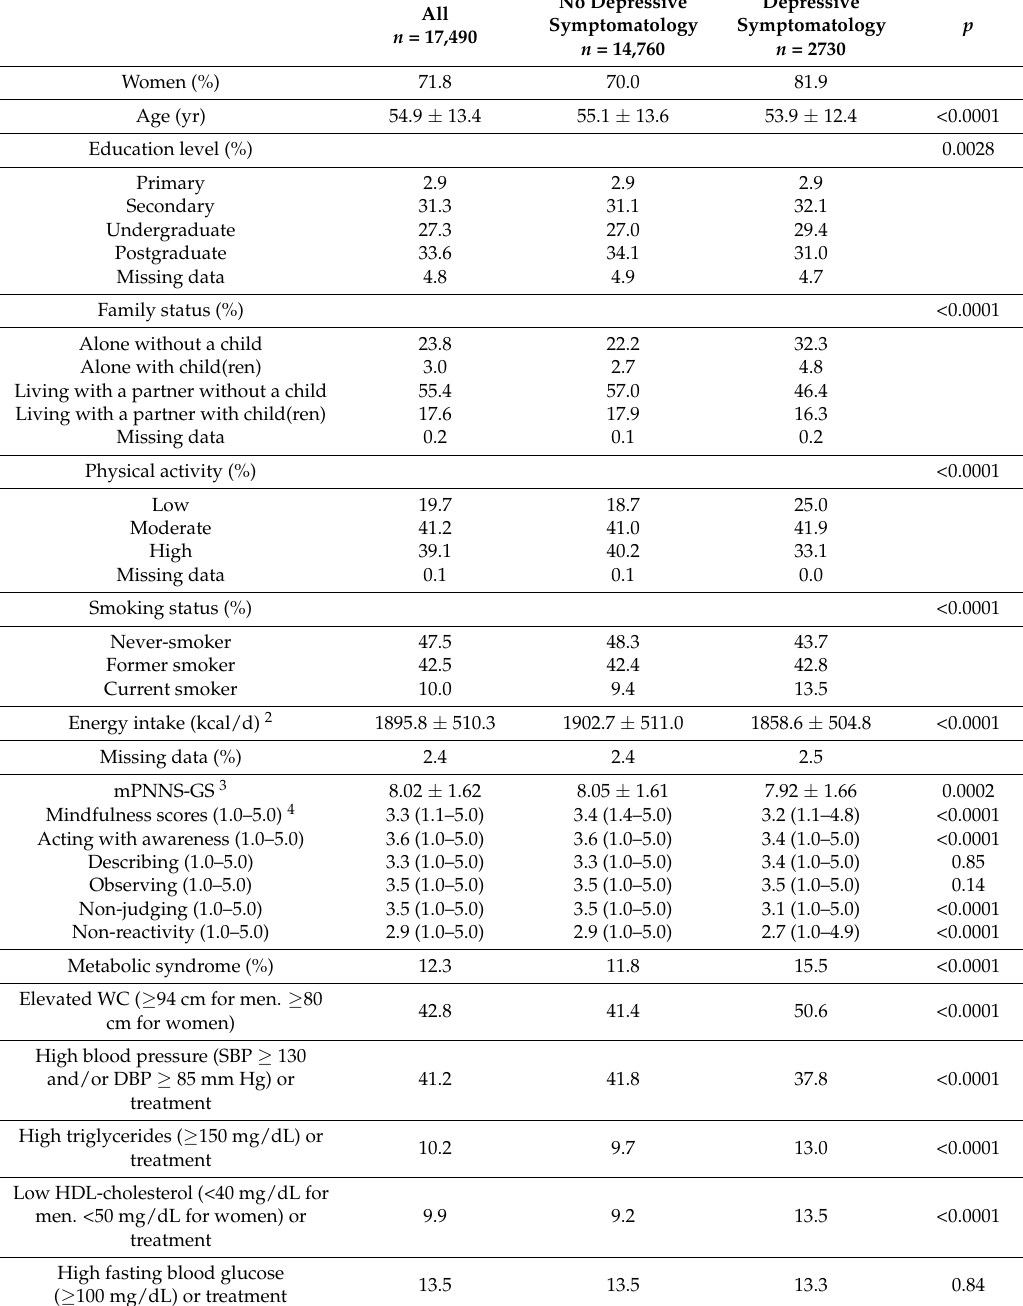
Table 1. Socioeconomic and lifestyle characteristics of the participants according to depressive symptomatology in 17,490 individuals (NutriNet-Sant é Study, France, 2011–2014) 1